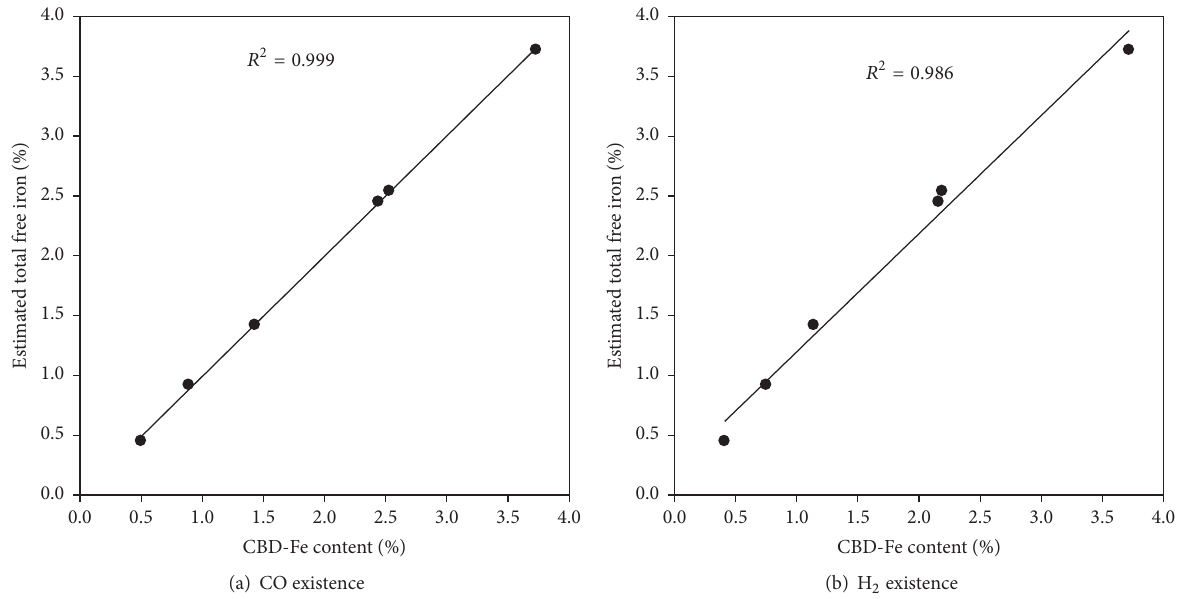
Figure 4: The regression relationship between CBD-Fe content and the estimated total free iron under the experimental condition of CO and H 2 , respectively.